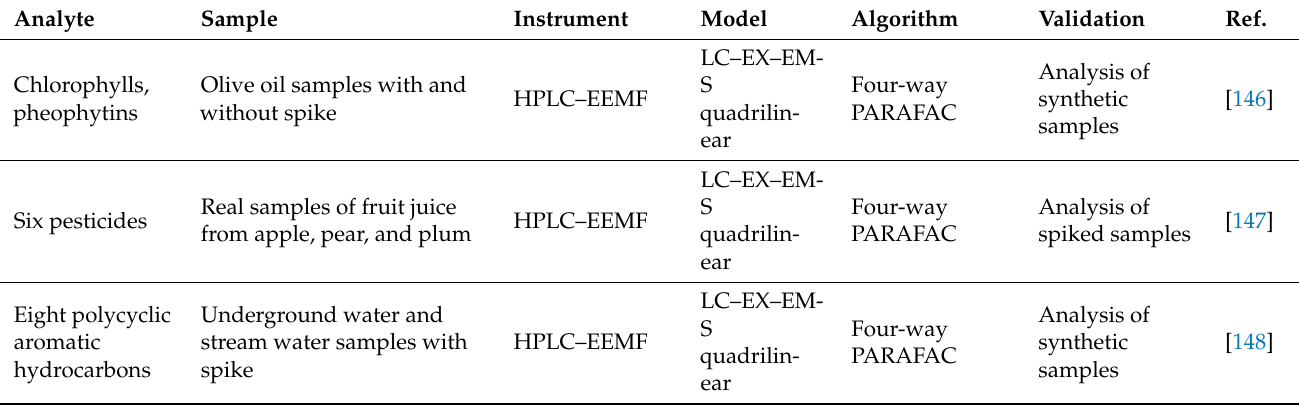
Table 3. Analytical applications of HPLC–EEMF assisted by four-way analysis based on the quadrilinear model. Analyte Sample Instrument Model Algorithm Validation